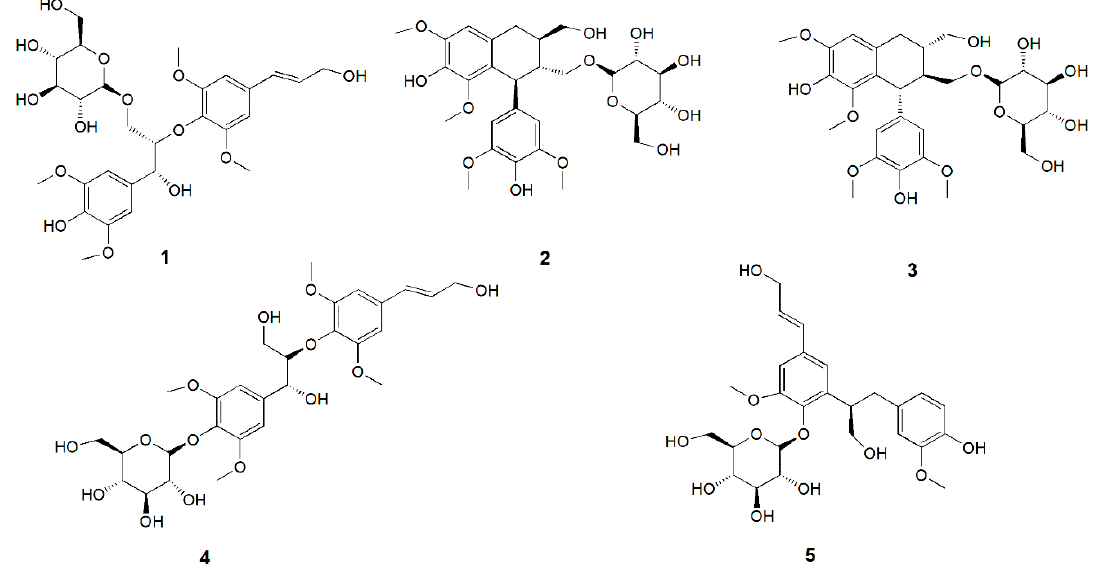
Figure 2. Chemical structures of compounds 1 – 5 identified from Albiziae Cortex .